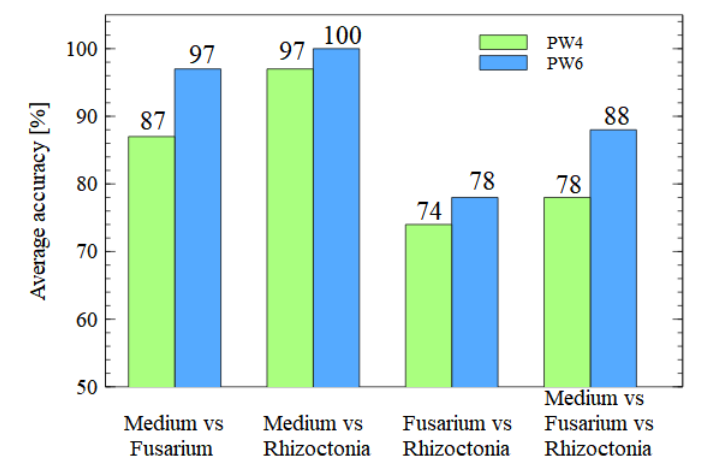
Figure 5. Comparison of the accuracy of the classification performance using data collected by the PW4 and PW6 electronic noses. Classification for binary or multinomial target models, as indicated on the x